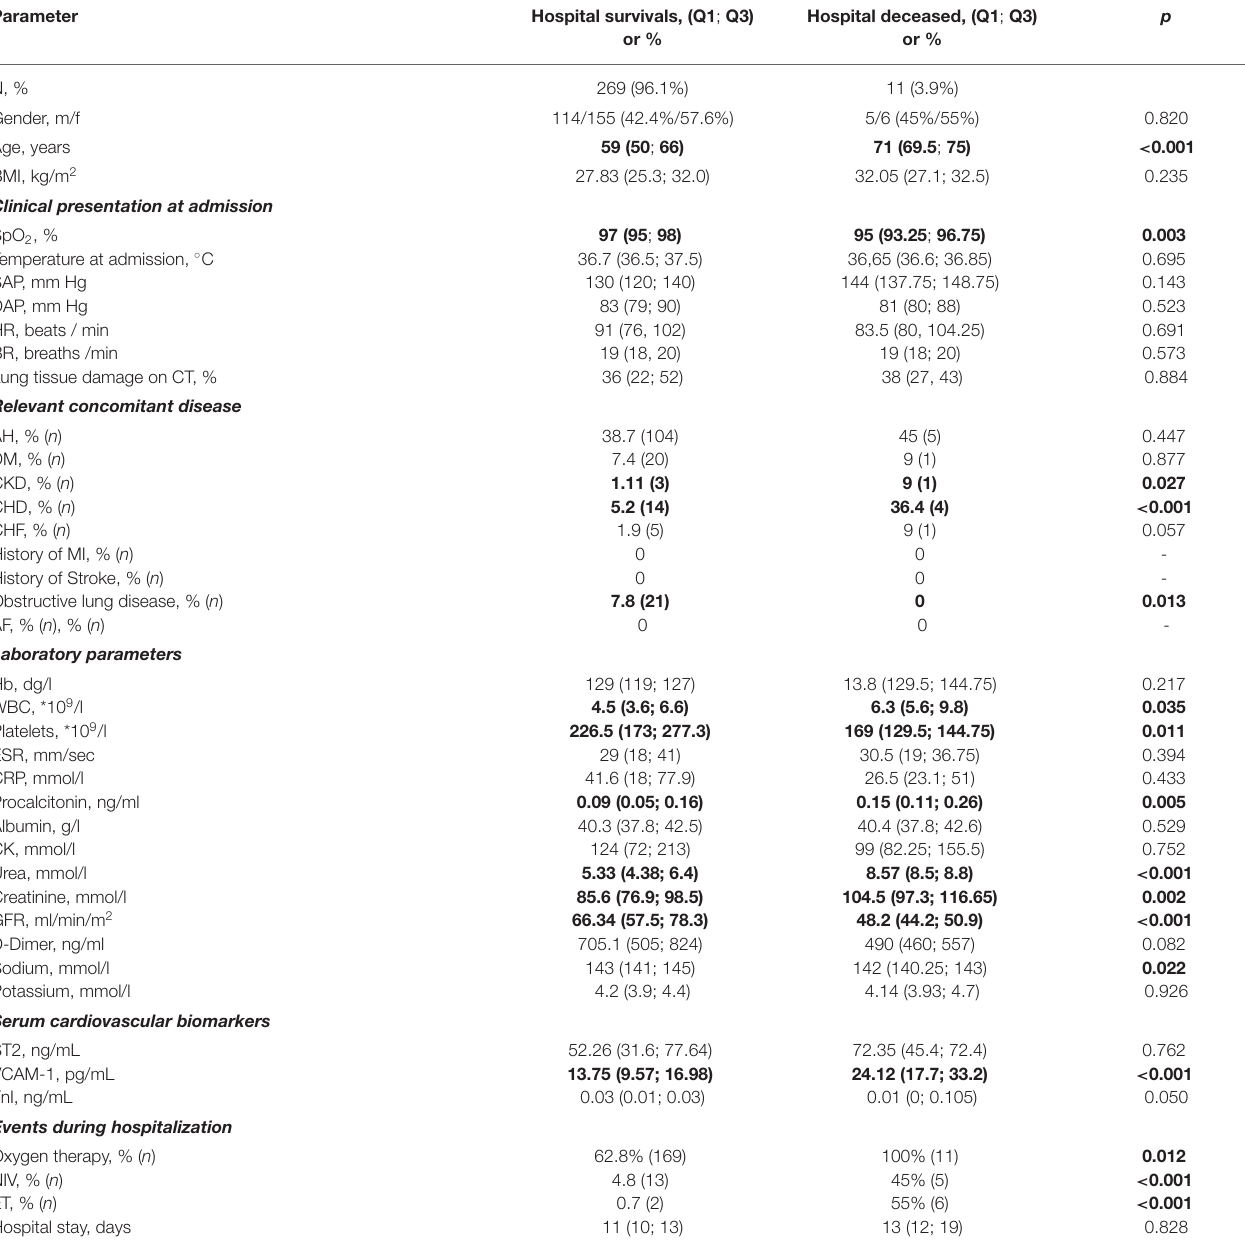
TABLE 2 | Comparison of COVID-19 in-hospital deceased vs. in hospital survivors. Parameter Hospital survivals, (Q1 ; Q3)